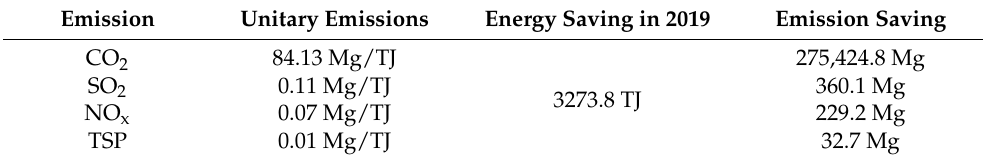
Table 2. Calculated absolute values of emissions reduction potential for the GZM.